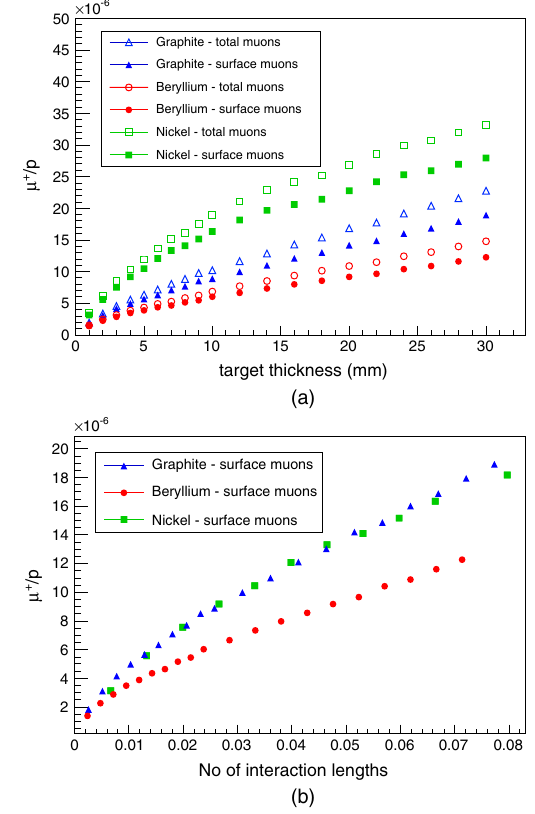
FIG. 2. The comparison of the muon yield per proton for three different materials. (a) Variation of the muon yield with the target thickness. (b) The muon yield as a function of the interaction length.